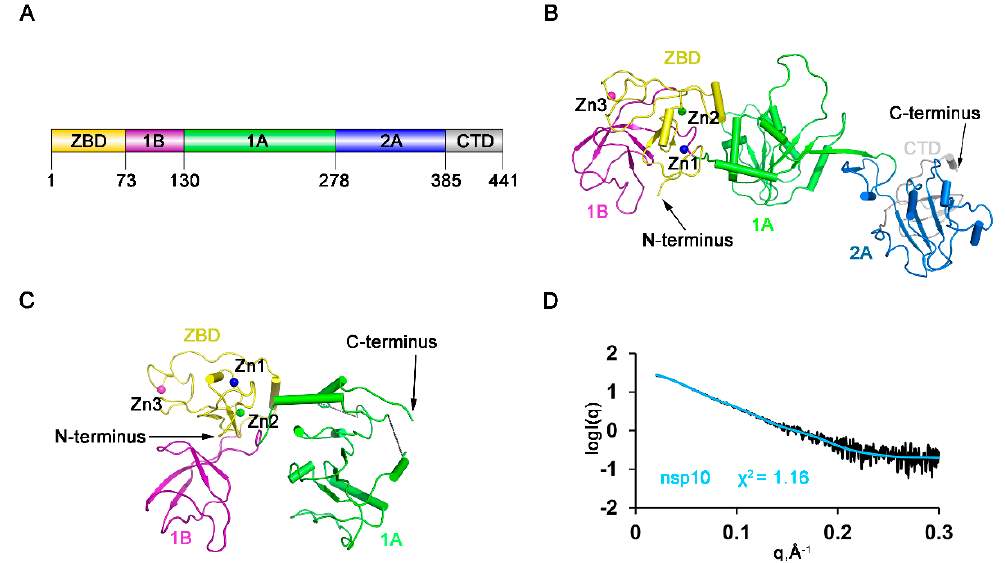
Figure 1. Overall structures of the full-length highly pathogenic porcine reproductive and respiratory syndrome virus (HP-PRRSV) nonstructural protein 10 (nsp10) and a truncated form. ( A ) Domain organization of PRRSV nsp10. PRRSV nsp10 contains an N-terminal zinc-binding domain (ZBD) (yellow), domain 1B (purple), two RecA-like domains 1A (green) and 2A (blue), and a C-terminal domain (CTD) (grey). Structures of ( B ) full-length nsp10 and ( C ) a truncated form lacking domains